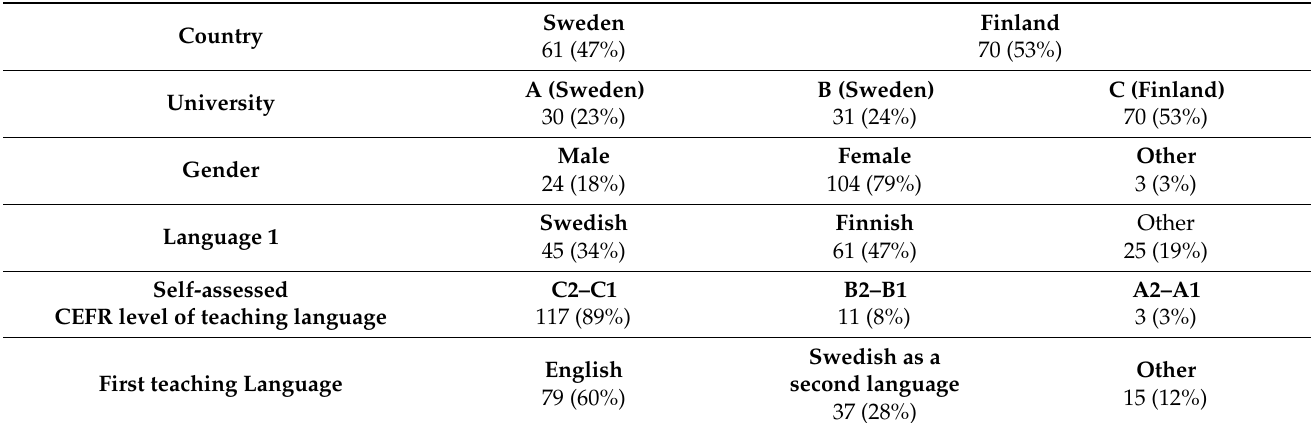
Table 2. Distribution of participants by background variables (N =